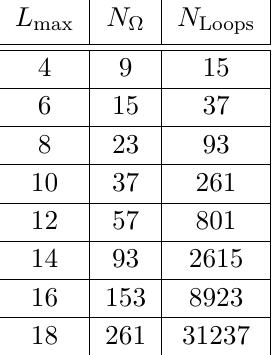
Table 1. Truncating loop